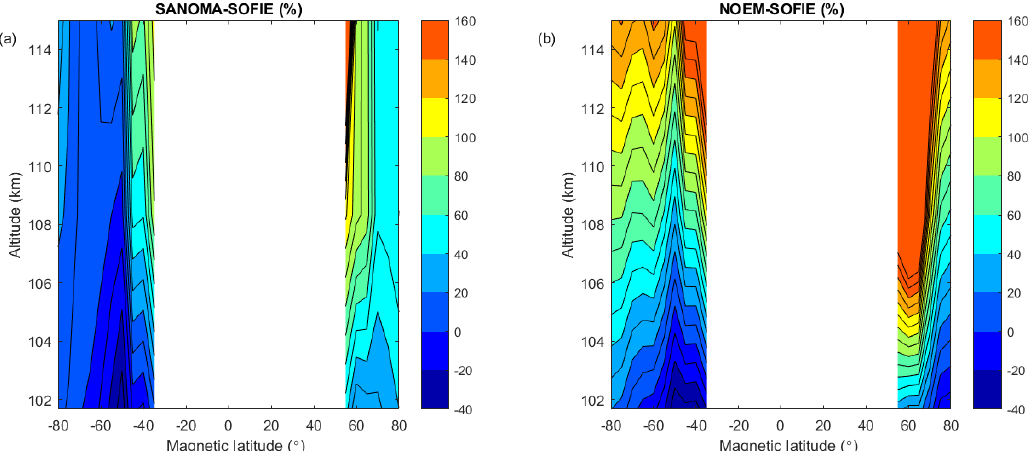
Figure 14. (a) Median difference between SANOMA and SOFIE as a percentage of mean SOFIE NO number density. (b) Median difference between NOEM and SOFIE as a percentage of mean SOFIE NO number